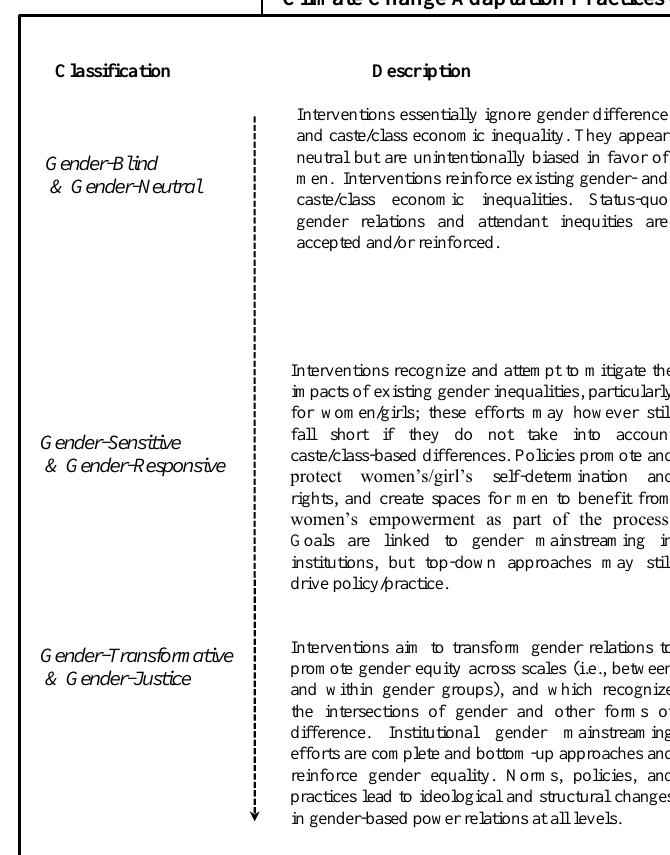
Figure 4. Climate change adaptation practices – gender intervention